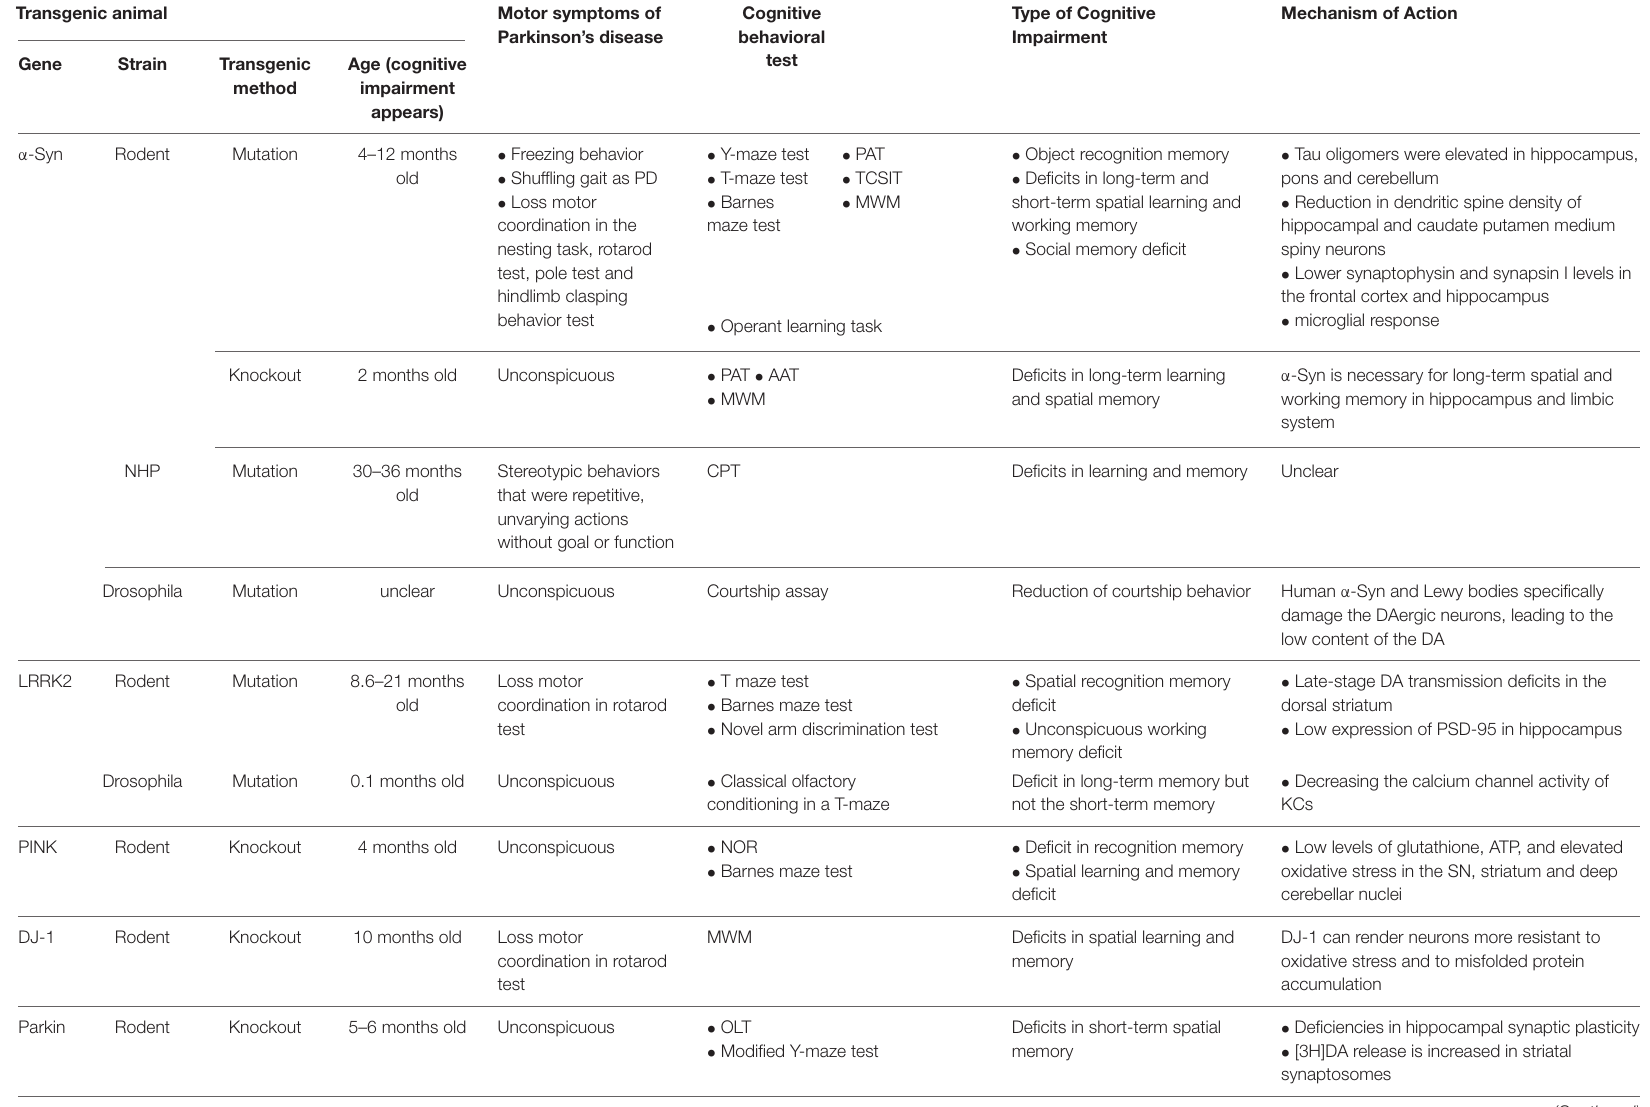
TABLE 5 | Methods of transgenic experimental